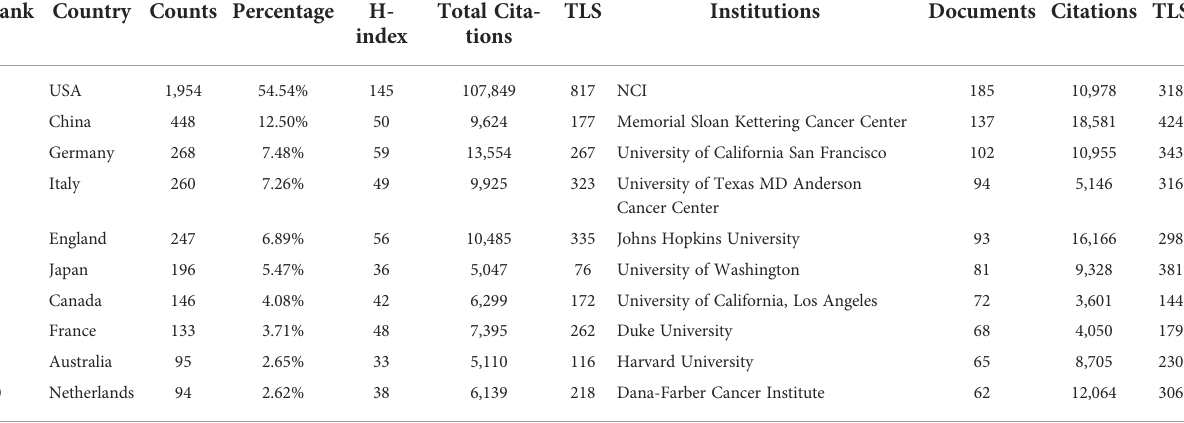
TLS, total link strength.